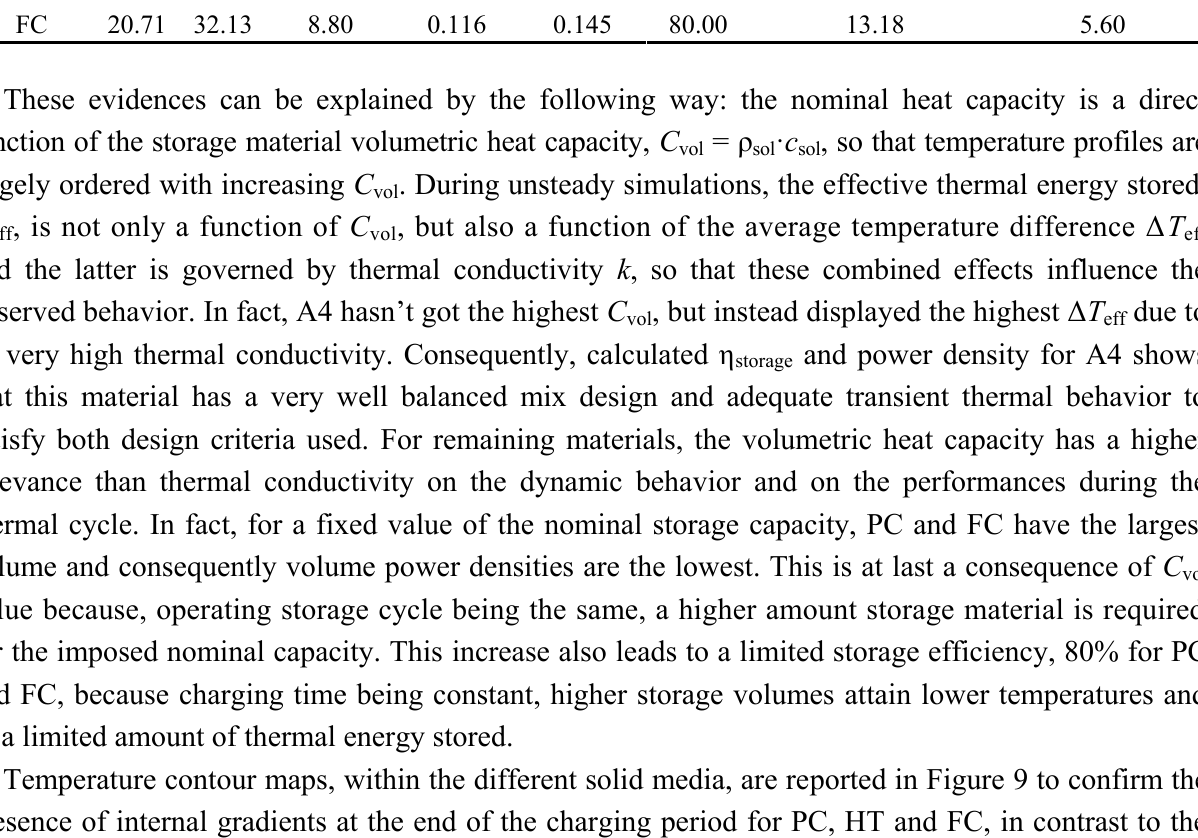
Table 5. Analysis results at constant Q